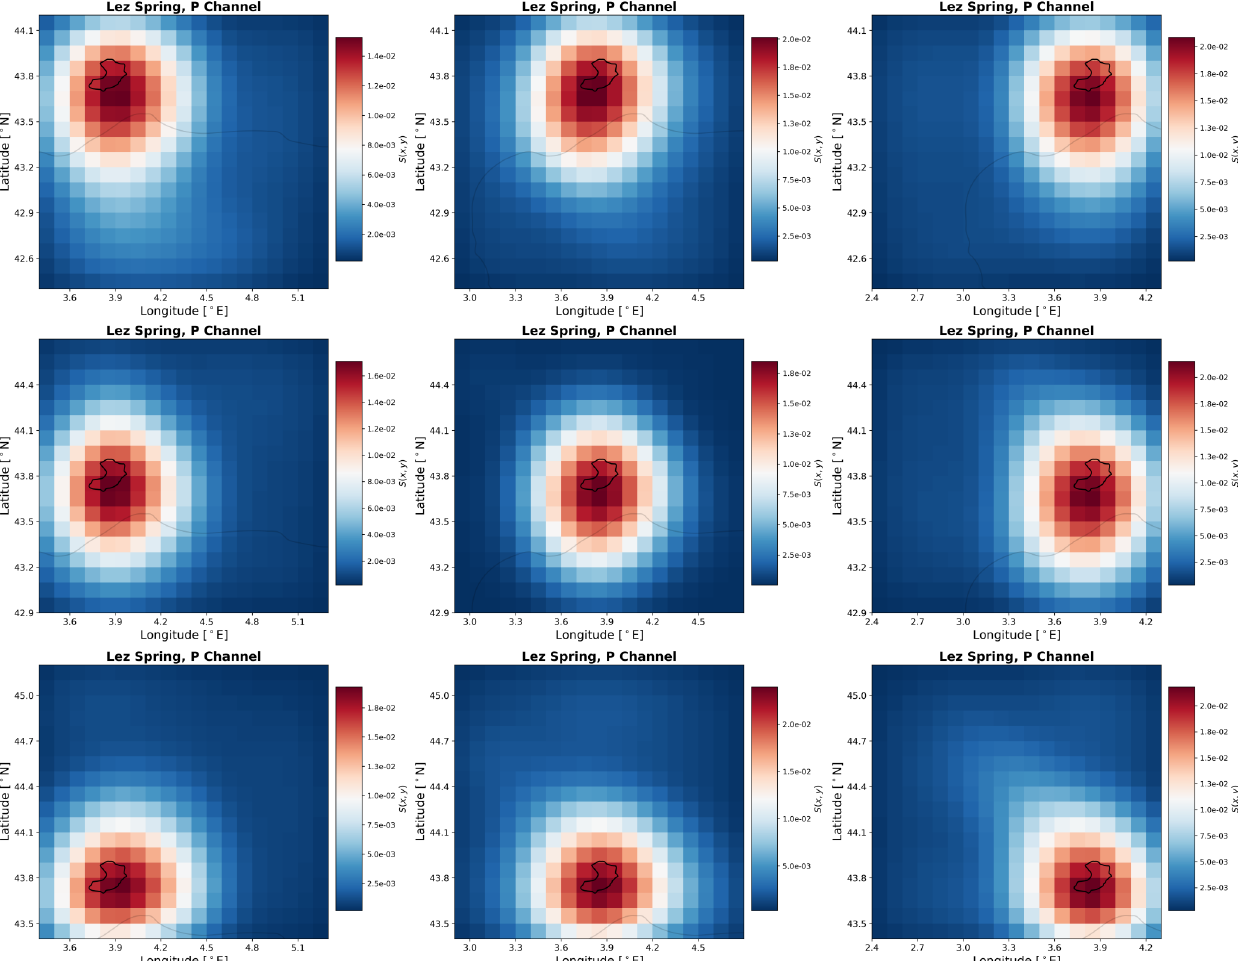
Figure C3. P-channel heat maps based on E-OBS gridded data for Lez spring with shifted area of the spatial input data in relation to the catchment